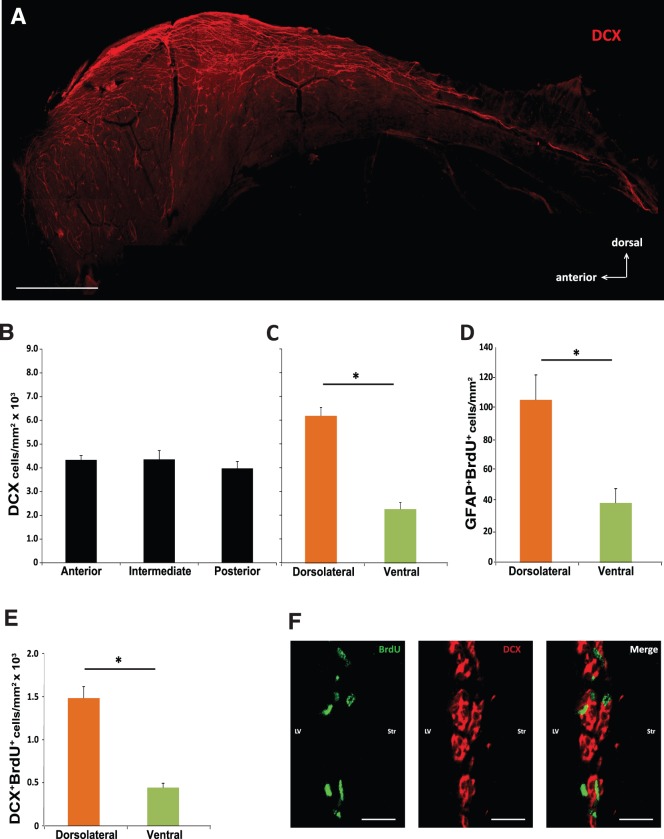
Neural stem and progenitor cells decrease along the subependymal zone dorsal-ventral axis.A DCX wholemount staining for the lateral wall is represented in (A) (Scale bar = 1 mm). DCX positive cell rates were estimated through the lateral wall for anterior, intermediate and posterior SEZ (B), dorsolateral and ventral SEZ (C). BrdU retaining cells were double stained with GFAP and assessed in the dorsolateral and ventral SEZ (D). The same analysis was performed for proliferating neuroblasts (double BrdU/DCX positive cells) (E). The images for the BrdU, DCX and BrdU/DCX staining are represented in (F) (Scale bar = 20 µm). LV, lateral ventricle; Str, striatum. All results are expressed as number of positive cells per area (in mm2). The threshold value for statistical significance was set at 0.05 (* p<0.05).